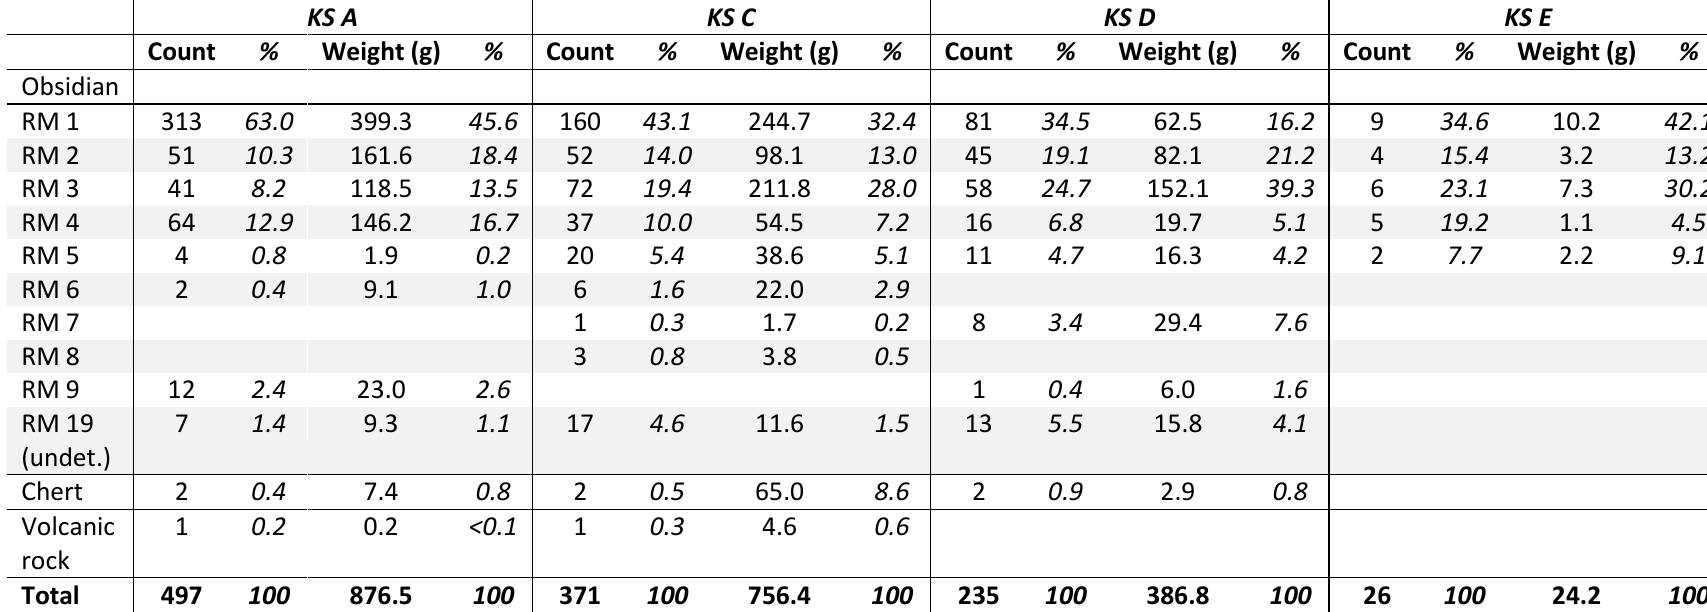
Table 2. Breakdown of raw materials (RM) according to numbers and weight. Abbreviations: undet. -